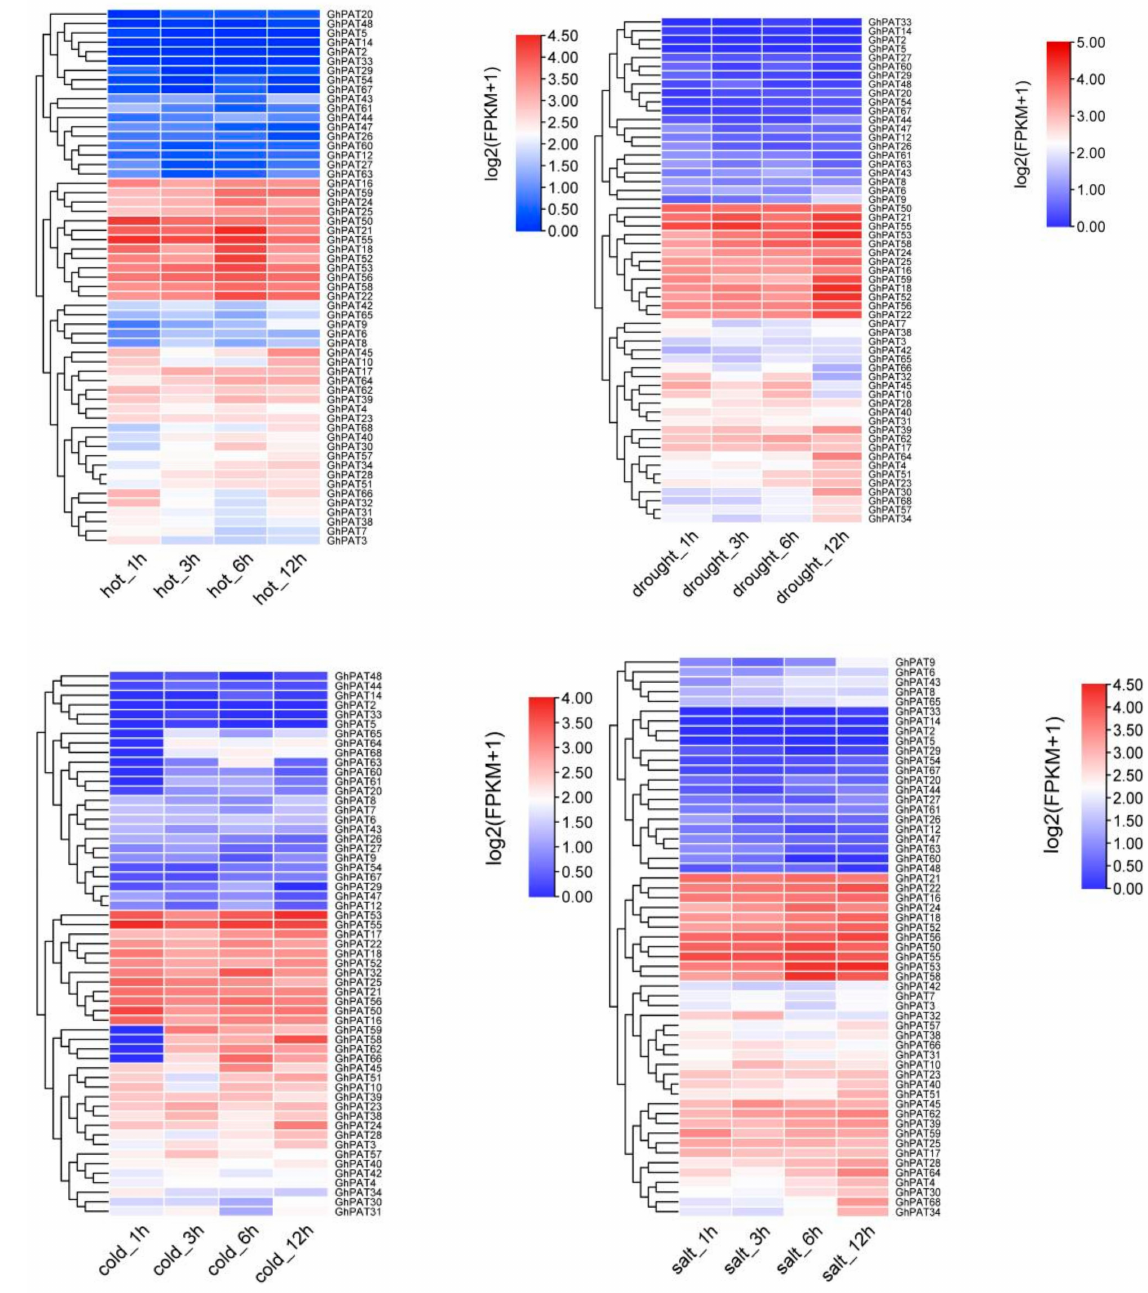
Figure 8. Expression of the GhPAT gene family under different stresses. In short, 9 genes ( GhPAT21 , GhPAT22 , GhPAT18 , GhPAT16 , GhPAT55 , GhPAT50 , GhPAT53 , GhPAT52 , GhPAT56 ) were simultaneously highly expressed under abiotic stresses induced by drought, salt, heat and cold. Three genes ( GhPAT21 , GhPAT24 , GhPAT58 ) showed a trend of high expression under all three stress treatments except for no difference in expression under cold treatment. GhPAT25 was highly expressed under cold, heat and drought treatments, with no dominant expression under salt stress treatment. This indicates that there is notable variability in gene expression under different stress treatments. Further studies are needed to investigate how PAT genes are regulated under different treatment